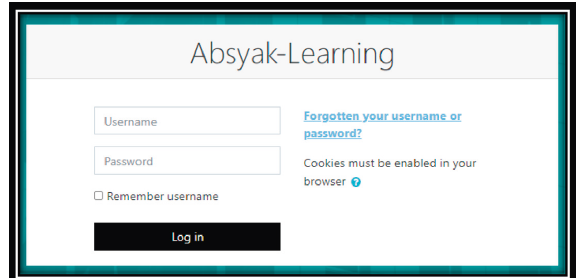
Figure 1: The homepage of “Absyak” application.